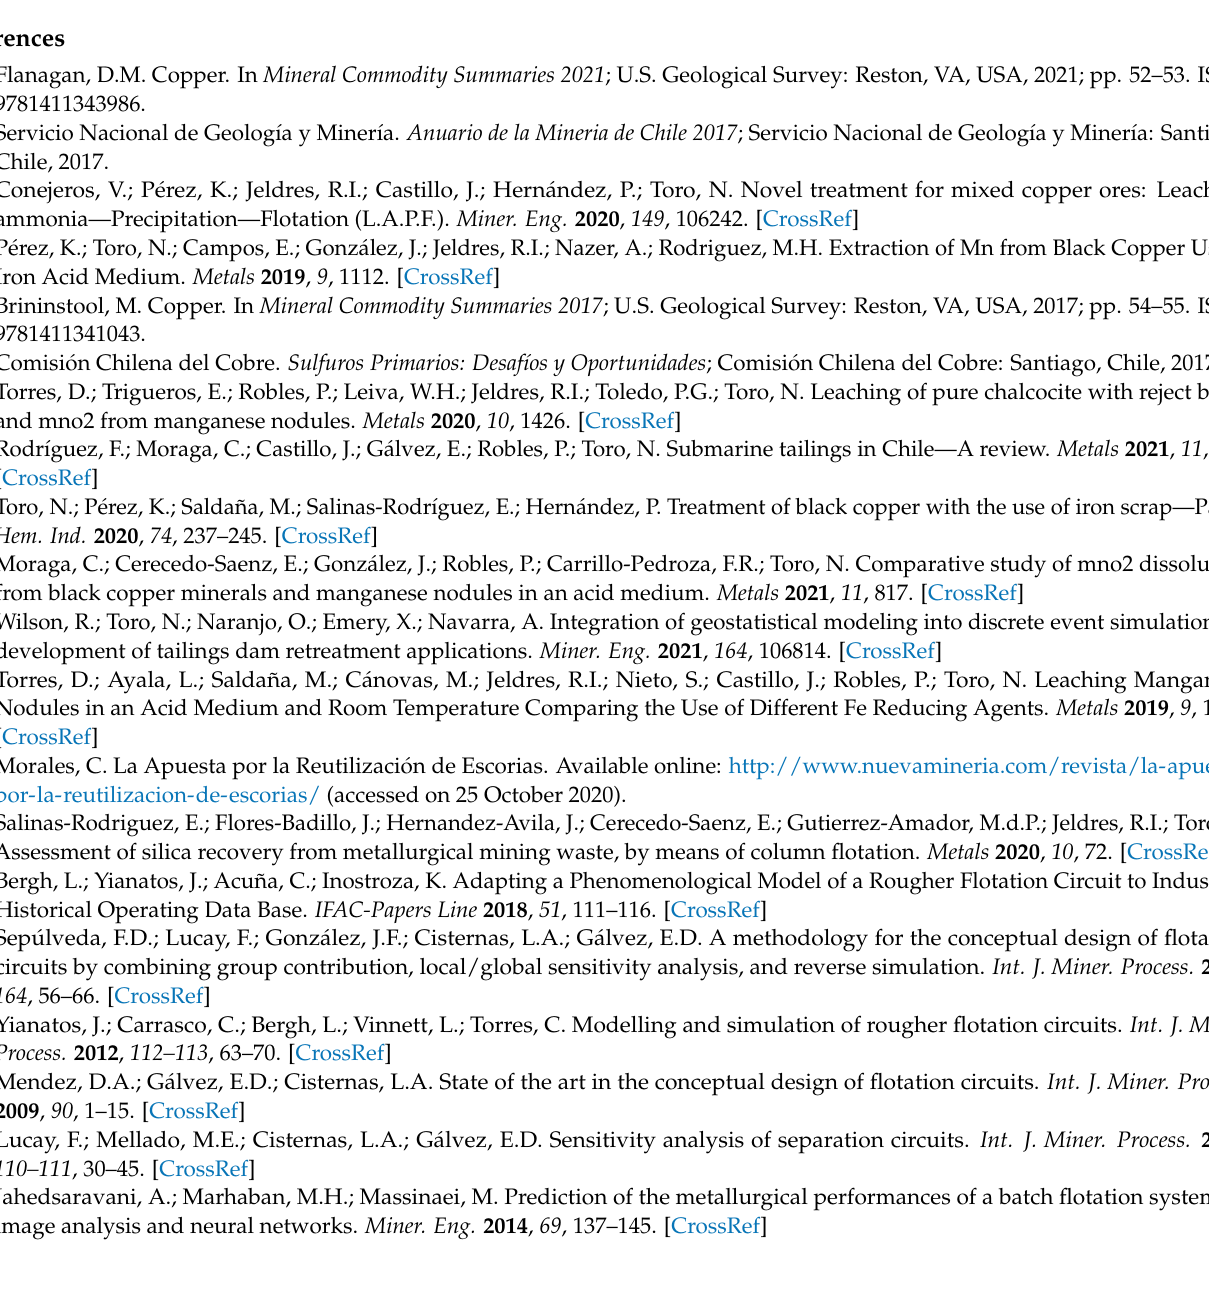
Figure A1. Stability model versus bubble particle contact